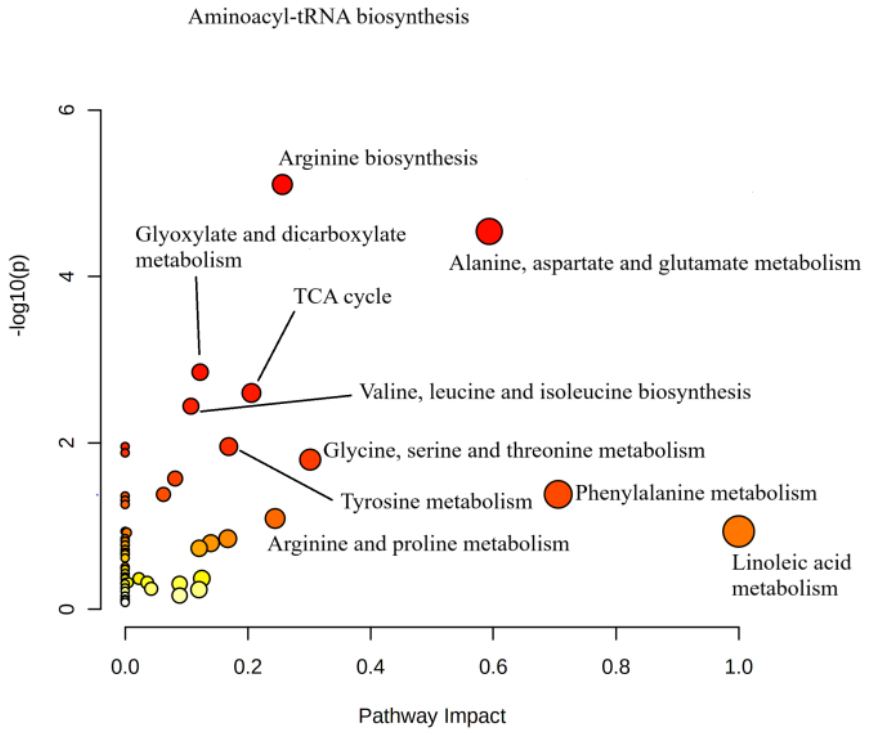
Figure 5. Metabolic pathway enrichment of biomarkers in tobacco seedlings.